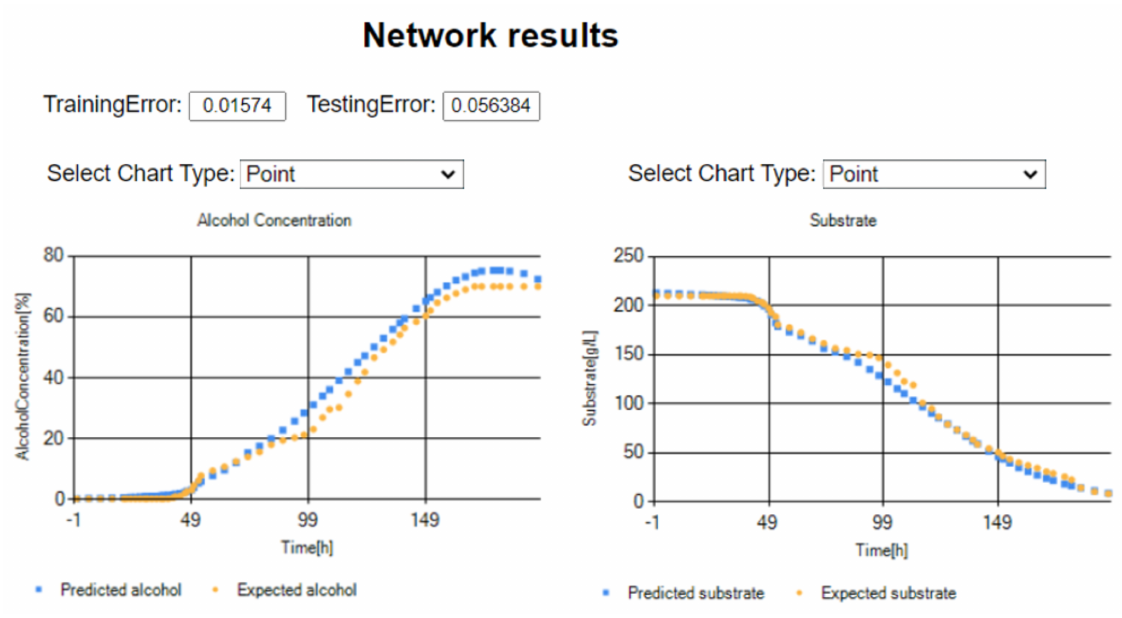
Figure 6. Results check